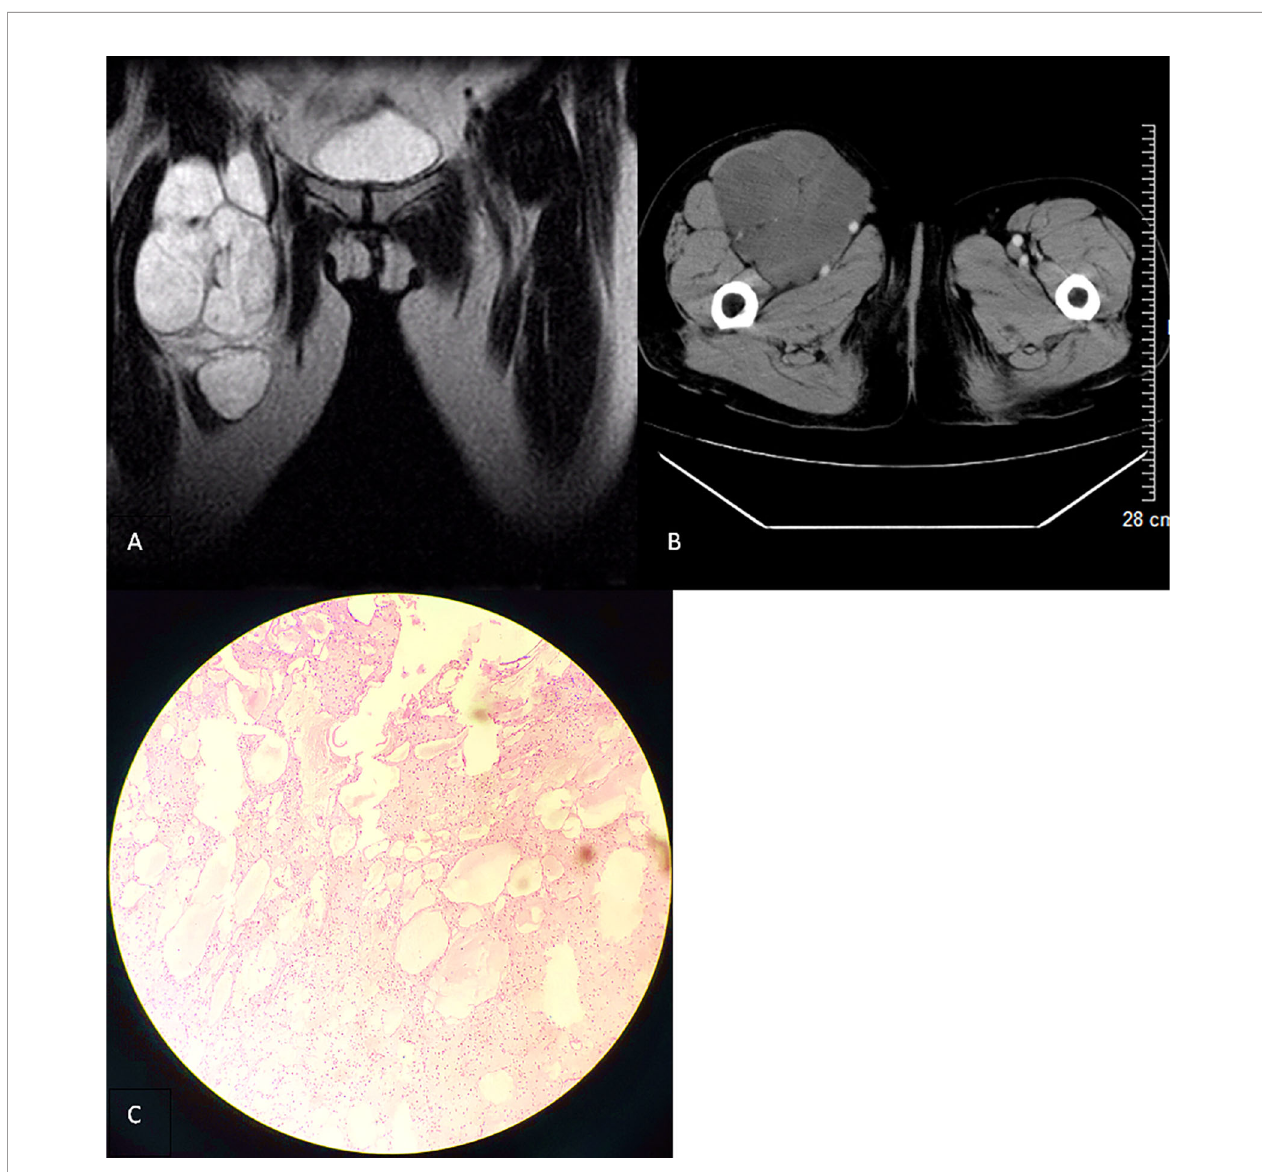
FIGURE 1 | (A) T2-weighted imaging in the coronal section (2008) revealing a polycystic lesion in the right inguinal region with smooth border and low-signal intensity septum. (B) Contrast-enhanced computed tomography scan in the transverse section of the lesion with no signi fi cant enhancement. (C) Microscopically, there are several unequal thin-walled cavities, the inner wall is lined with monolayer fl at epithelial cells, the cavity is full of protein fl uid, the endothelial cells are loose, the nucleus is small, and no atypia is found (hematoxylin and eosin stain,